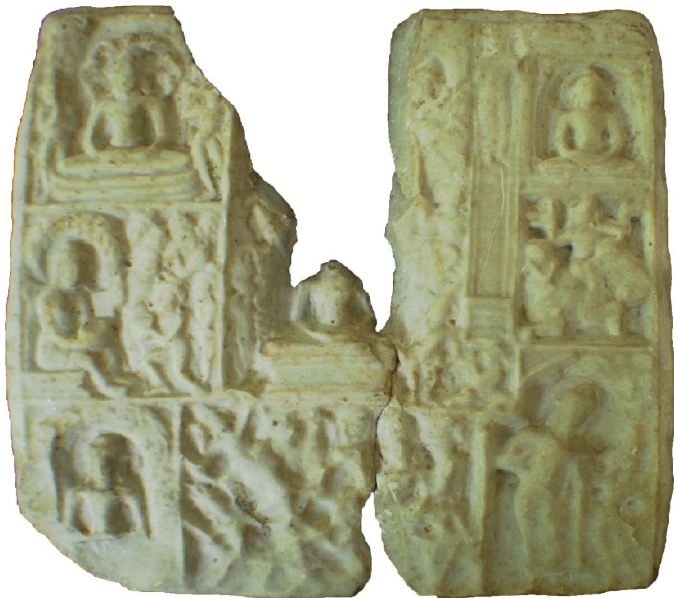
Figure 1. Relief depicting the Seven Weeks after the Buddha’s enlightenment, Rankirimada Rajamah ā Vih ā ra, Sri Lanka.